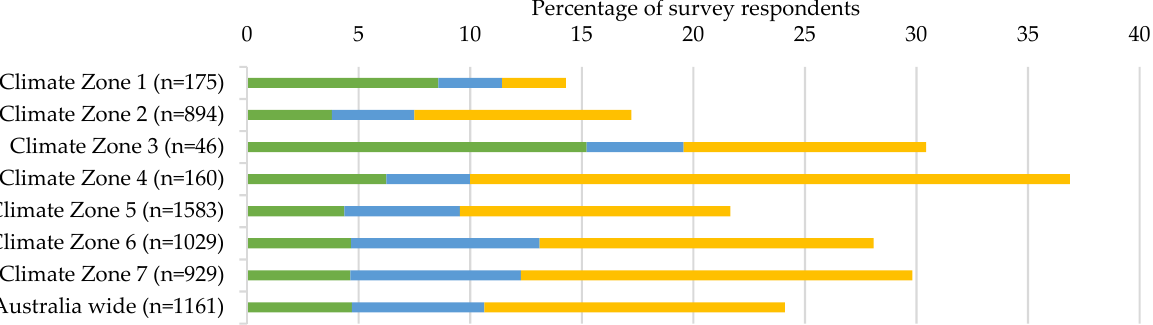
Figure 1. Percentage of survey respondents who reported using firewood in each GCCSA location across Australia. In terms of climate zone, the use of firewood for indoor space heating was signifi- cantly lower in climate zones with warmer winters (e.g., climate zones 1 and 2, which are characterised by warm winters) and higher in climate zones with cooler winter (e.g., cli- mate zone 4, which is characterised by cool winter, and climate zone 6 and 7, which are characterised as mild and cool temperate, respectively).